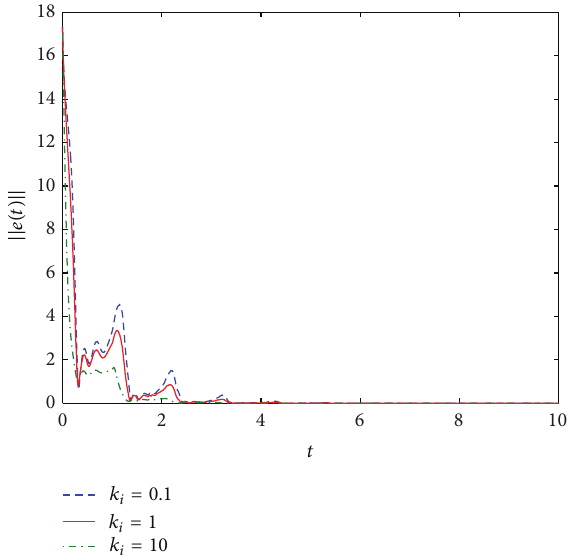
Figure 4: Total synchronization errors ‖𝑒(𝑡)‖ with 𝑘 𝑖 = 0.1, 1, 10